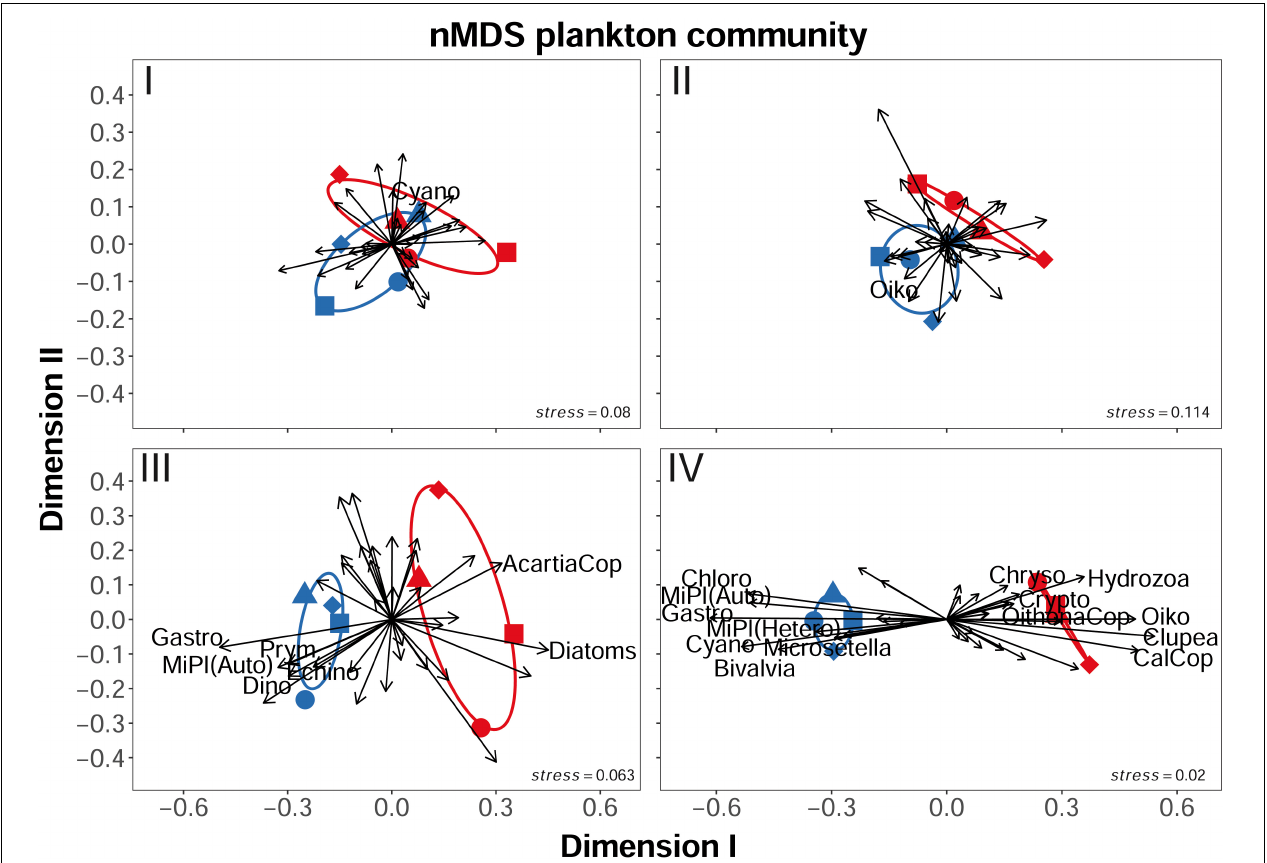
FIGURE 7 | Non-metric dimensional scaling (nMDS) plots of range normalized mesocosm plankton community data for the different phases of the experiment. (I) The initial phase before CO 2 addition. (II) Establishing of target p CO 2 values and transition from bloom to post-bloom conditions. (III) First phase of post-bloom conditions and treatment effect. (IV) Final post-bloom phase. Stress values indicate how accurate dissimilarities among plankton communities in the mesocosms are depicted, arrows indicate the role of the various plankton groups for spatial organization of the mesocosms. AcartiaCop = Acartia spp. copepodites, CalCop = Calanus spp. copepodites, Chloro = Chlorophyceae, Chryso = Chrysophyceae, Clupea = Clupea harengus larvae, Crypto = Cryptophyceae, Cyano = Cyanophyceae, Diatoms = Bacillariophyceae, Dino = Dinophyceae, Echino = Echinodermata larvae, Gastro = Gastropoda larvae, MiPl (Auto) = autotrophic microplankton, MiPl (Hetero) = heterotrophic microplankton, OithonaCop = Oithona spp. copepodites, Oiko = Oikopleura dioica , Prym = Prymnesiophyceae. Figure created with the ggplot2 package in RStudio (Rstudio Team, 2016; Wickham et al.,